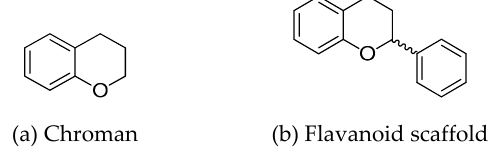
Figure 4. General structures of chroman and flavonoid scaffolds.